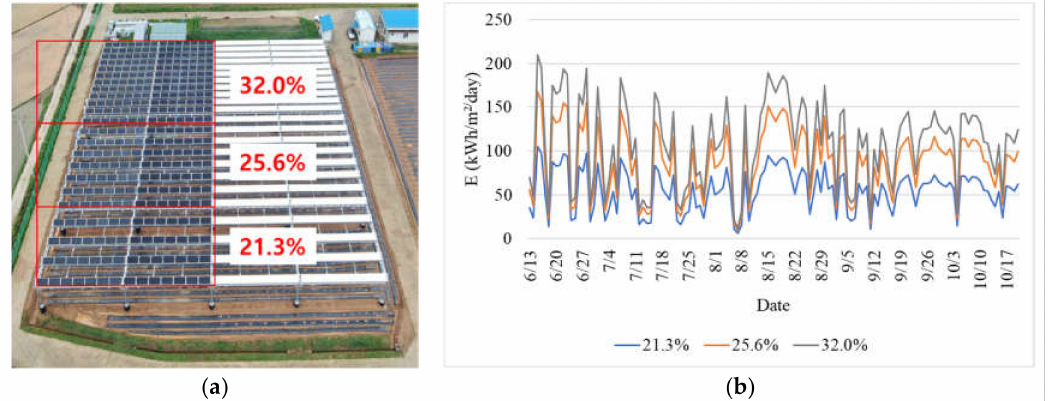
Figure 1. Overview of the APV system: ( a ) APV with three different shading ratios; ( b ) Electricity generation by the APV system. APV: